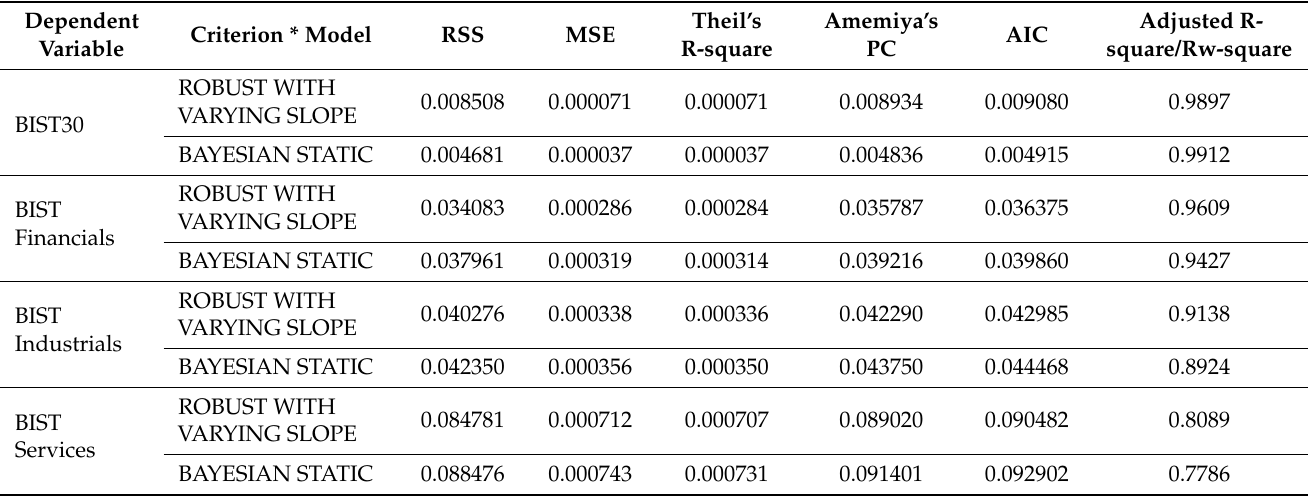
Table 10. Comparison between robust and Bayesian